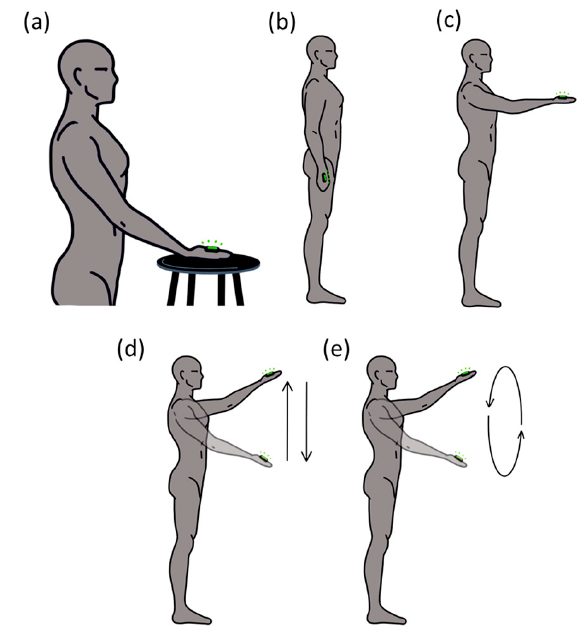
Figure 1. The sequence of the five different tasks: ( a ) placing the dominant hand on a stable surface (HoS); ( b ) keeping the arm extended down by the participant’s side in a relaxed position (ARelax); ( c ) keeping their arm extended in front of them, with the shoulder at 90° with respect to the vertical axis (A90); ( d ) from the c situation, participants performed oscillatory movements up and down in a range of 30 cm using a line placed in front of them (UpDown) as a reference; ( e ) from the c situation, participants performed circular movements following a circle (30 cm diameter) placed in front of them (Circle).